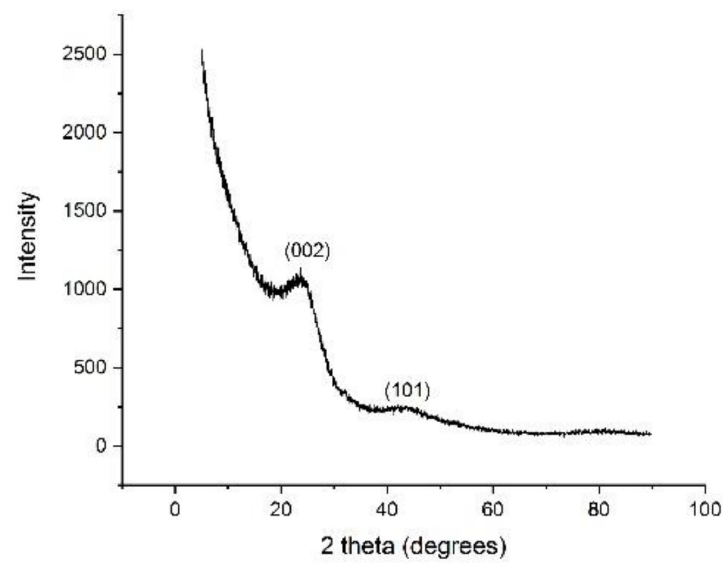
Figure 1. X-ray diffraction pattern of as-synthesized mesoporous carbon.